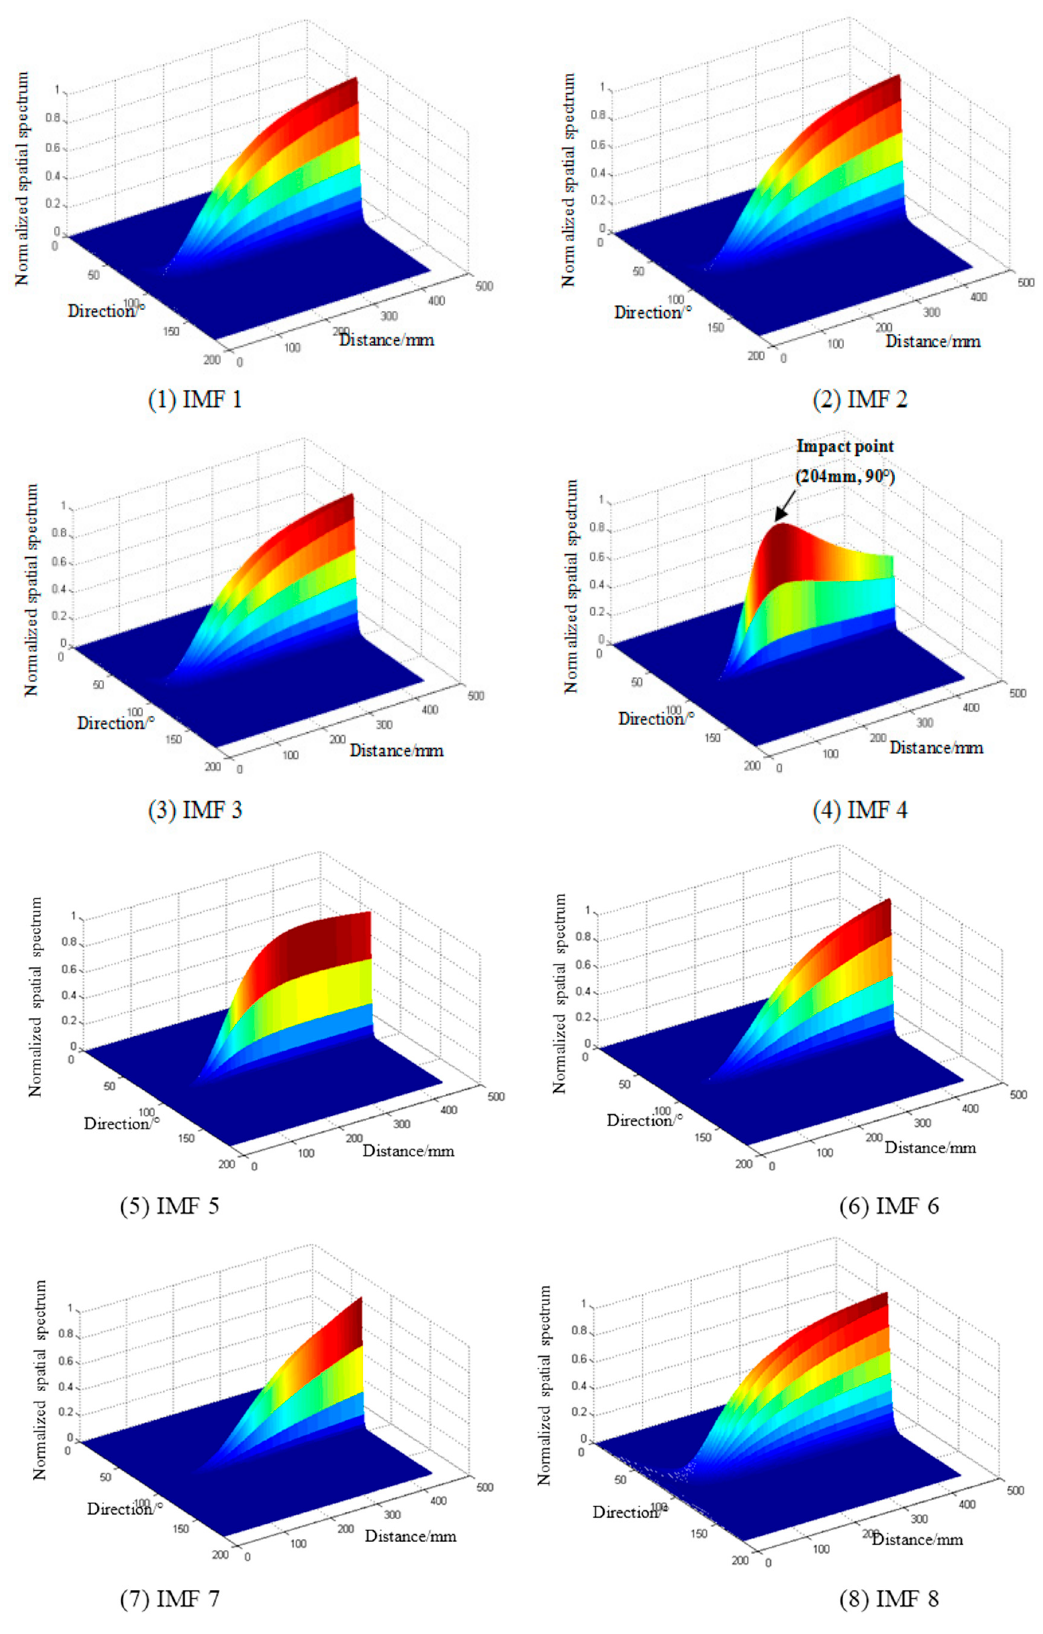
Figure 5. The spatial spectrums of each IMF estimated by the 2D-MUSIC model.